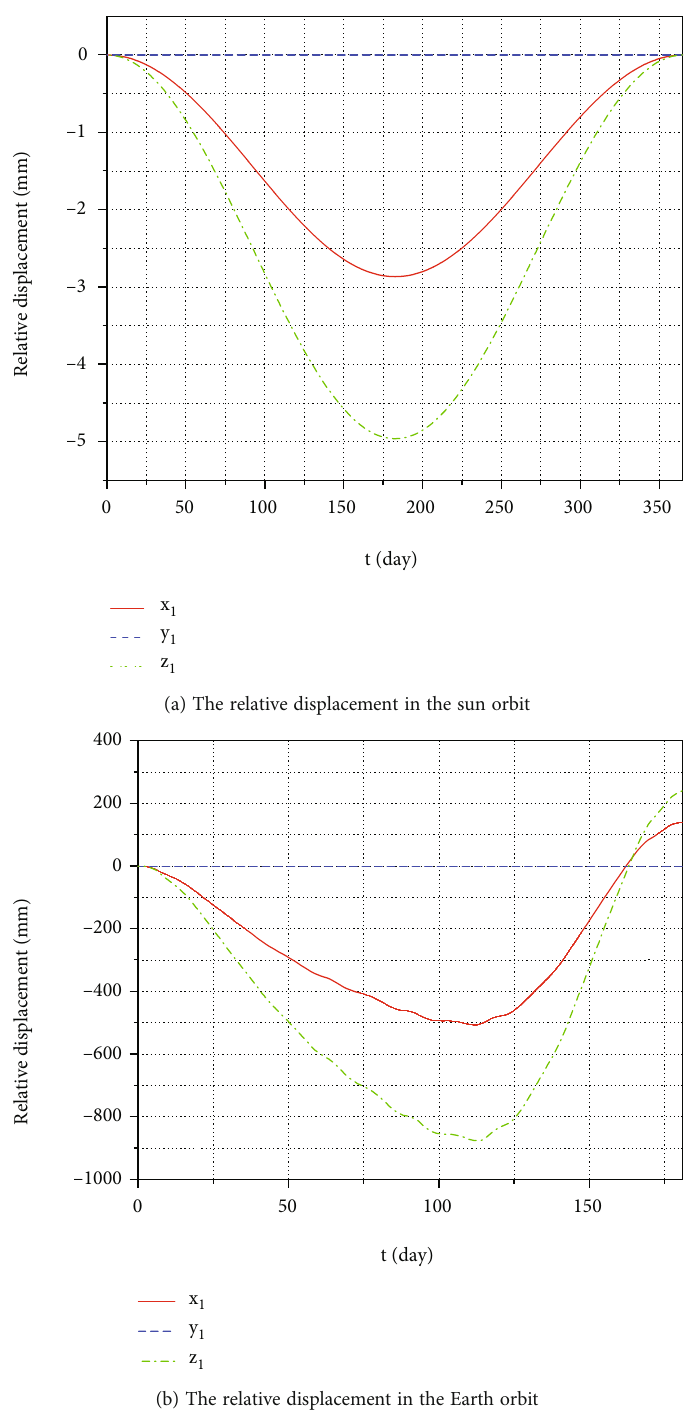
Figure 2: The relative displacement of the sun orbit and Earth